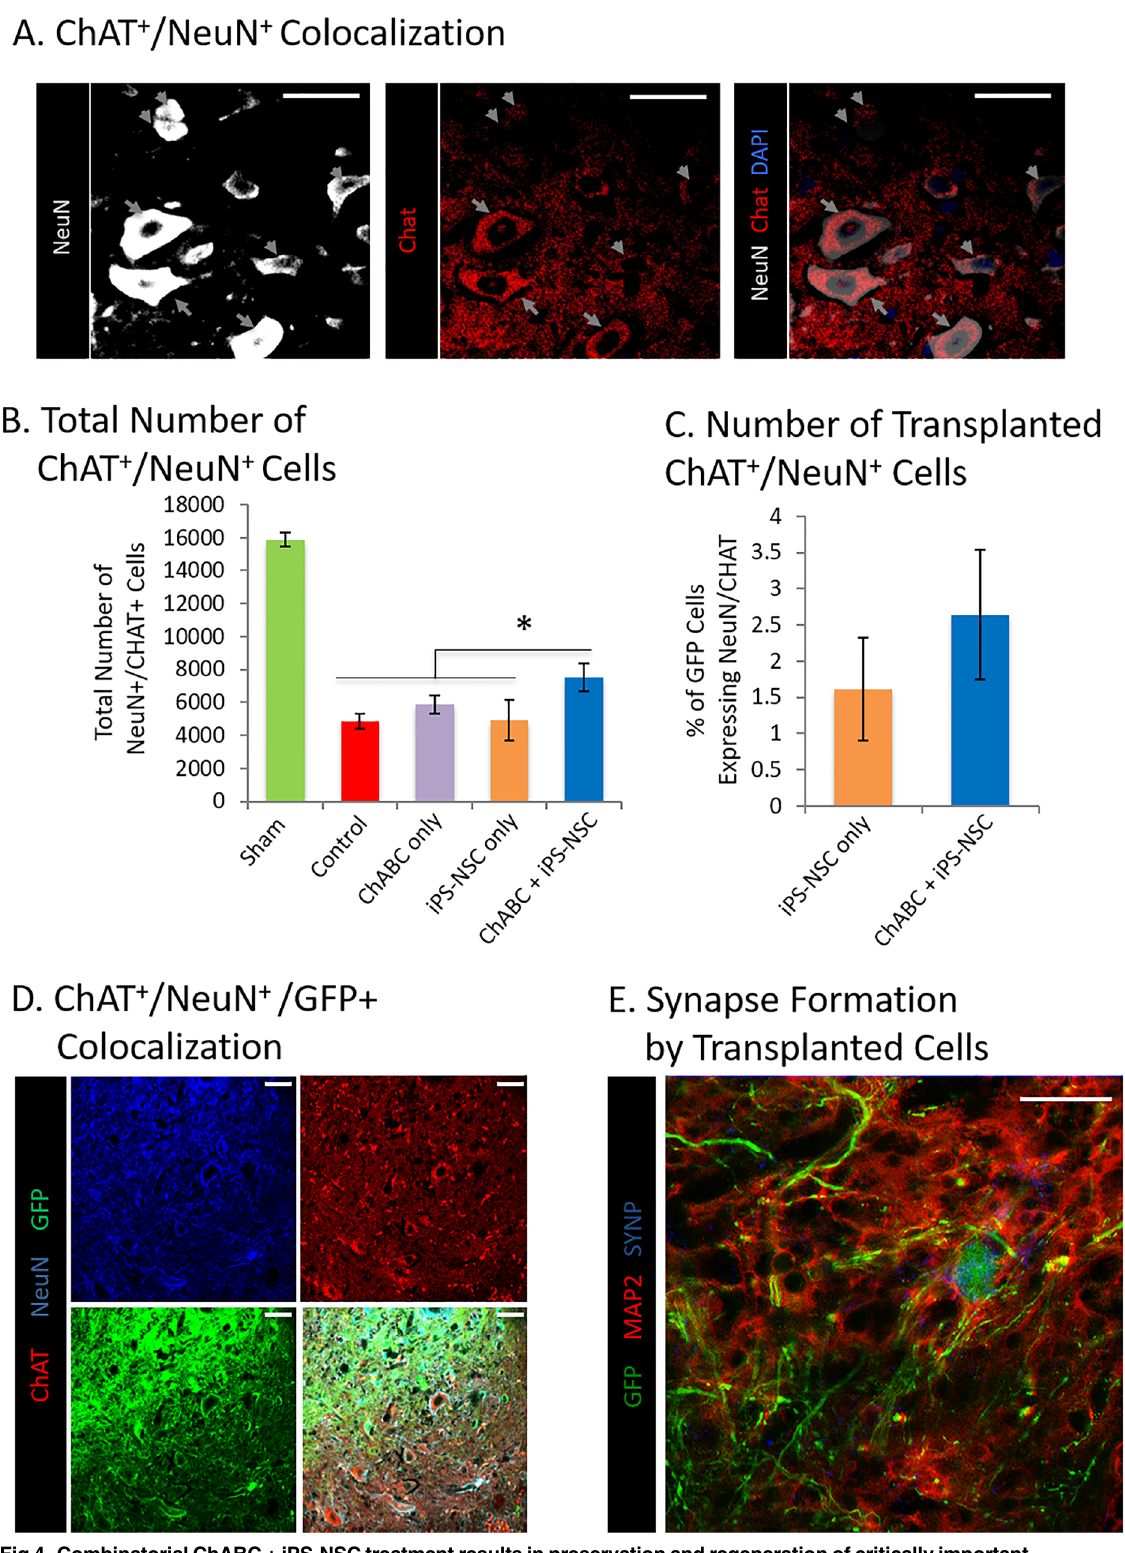
Fig 4. Combinatorial ChABC + iPS-NSC treatment results in preservationand regeneration of critically important acetylcholinergic neurons. (A) Representative imagesof ChAT + and NeuN + colocalization (gray arrowheads) in cells withinthe